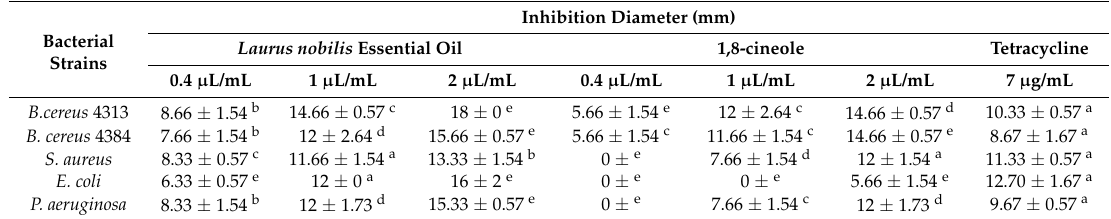
Table 2. Antimicrobial activity the EO of Laurus nobilis and